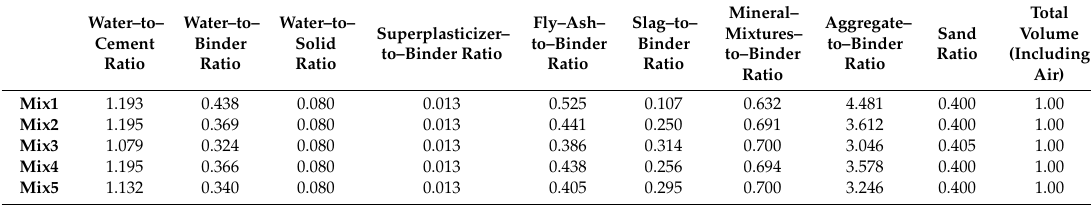
Table 8. The component ratio of each mixture of concrete.